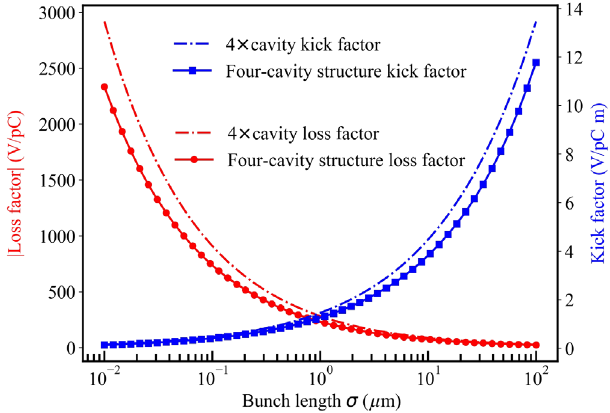
10. The absolute value of the loss factor and the kick factor for the four-cavity structure (solid lines with symbols). Four times the equivalent quantities for a single cavity are shown in the dash- dotted